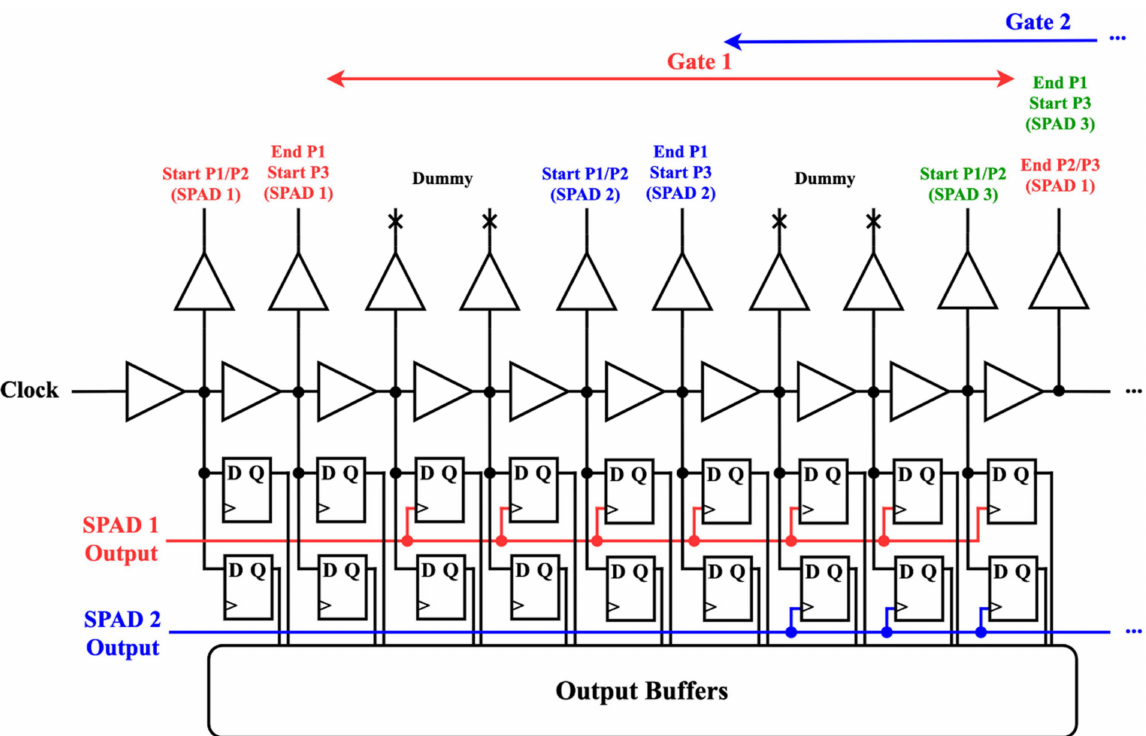
Figure 6. Simplified schematic of the multi-purpose delay line